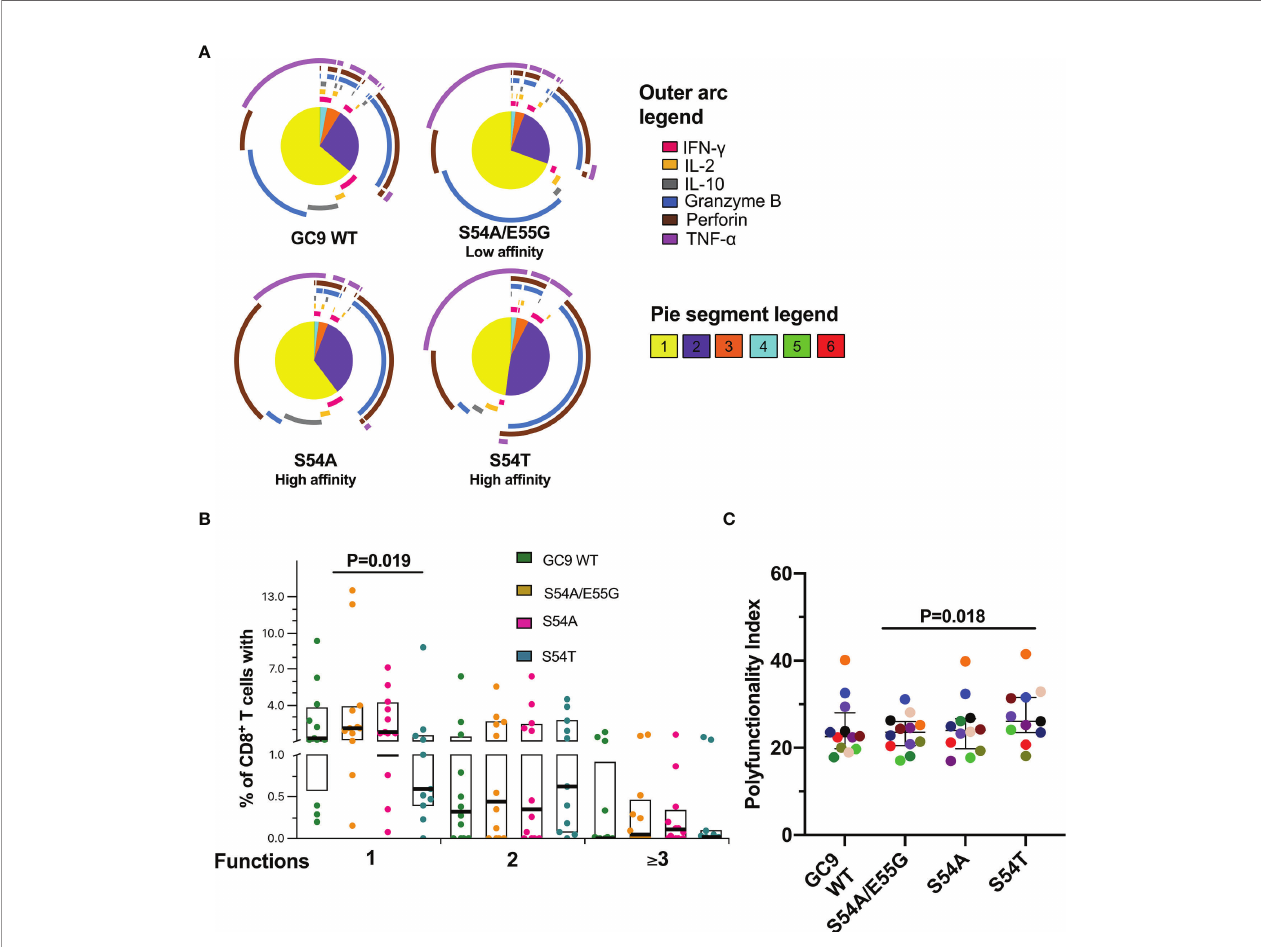
FIGURE 4 | Functional pro fi le of CD8 + T-cell response to GC9 WT, S54A/E55G, S54A and S54T. (A) Pie charts represent the average frequencies of CD8 + T-cells cells secreting cytokines and cytotoxic molecules producing every possible combination of the six molecules analyzed in response to GC9 WT and mutated peptides (10 µg/mL). The size of the pie segment correlates to the frequency of the particular population. The arcs around the circumference indicate the particular molecule (see outer arc legend) produced by the proportion of cells that lie under the arc. Parts of the pie surrounded by multiple arcs represent polyfunctional cells. (B) Percentage of cells responding through one, two, or more than three functions. (C) Polyfunctionality index. Wilcoxon test was used for matched-paired samples and comparisons were made between each mutated peptide with the wild type version (GC9 WT), but also among mutated variants. Plots depict the median and IQR, n =